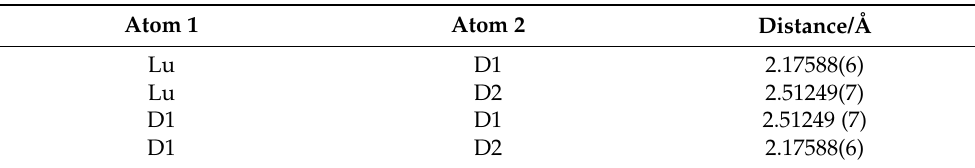
Table A4. The interatomic distances in LuD 1.985(19) up to 3 Å based on neutron diffraction data at ambient temperature.